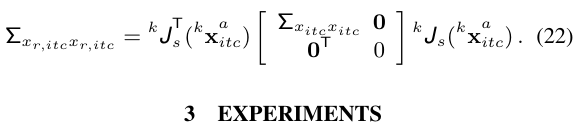
Figure 3: Simulation of a moving multi-camera system (poses shown as tripods) – e.g. on a parking lot – with loop closing. Scene points on the parking lot (crossed dots) and at the horizon (empty dots) being numerically at infinity are